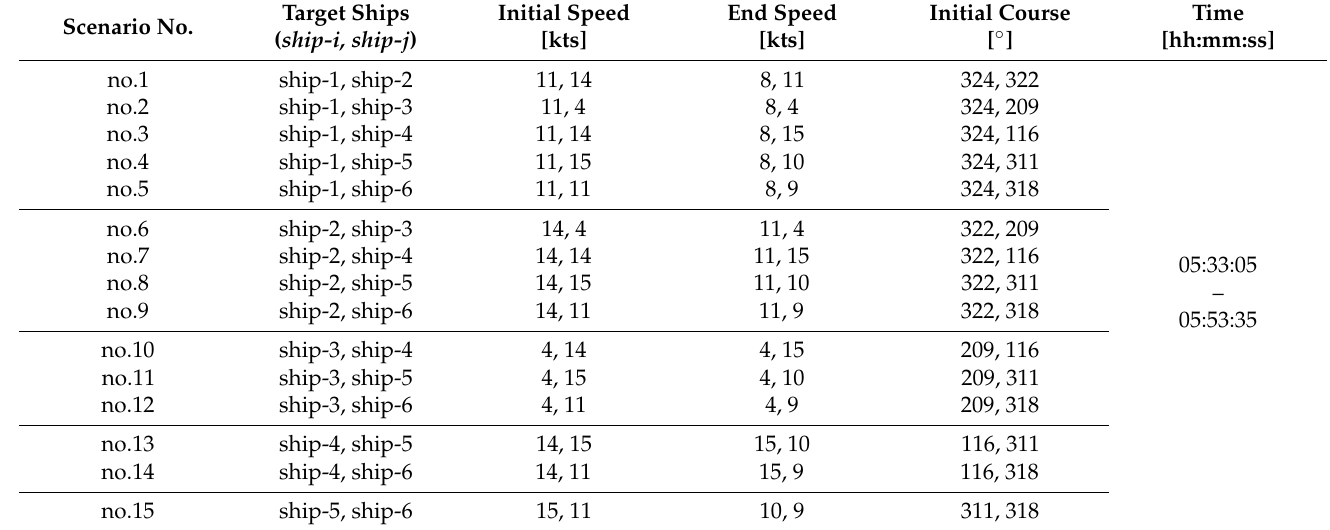
Table 2. Scenario combinations for target ships under near-collision situations in Busan Port VTS area during time 05:33:05–05:53:35. Scenario